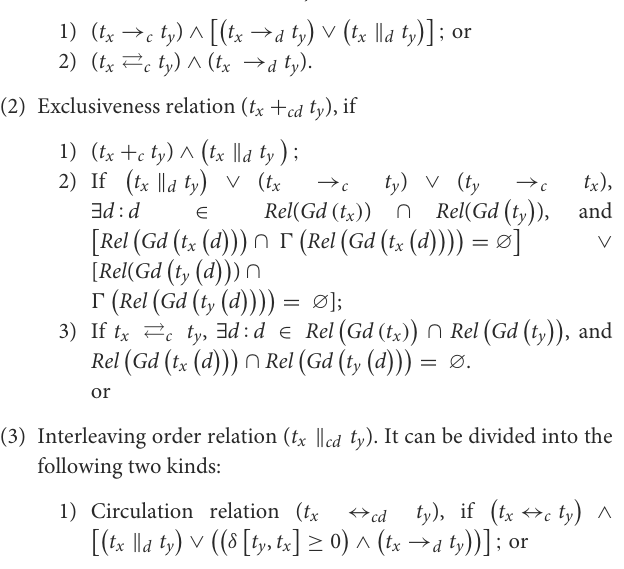
For the transition t y in Figure 2C, we have (1) Rel ( Gd t y ) is { a , b } , and Rel ( Gd t y ( a ) )(resp. Rel ( Gd t y ( b ) ) (cid:0) (cid:1) (cid:0) (cid:1) (cid:0) (cid:1) is a > 0 (resp. b ≤ 0) in guards related to t y ; and (2) Ŵ ( Rel Gd t y ) is the set of final values of { a , b } in (cid:0) (cid:0) (cid:1)(cid:1) Rel ( Gd t y ), and Ŵ ( Rel Gd t y ( a ) )(resp. Ŵ ( Rel Gd t y ( b ) ) (cid:0) (cid:1) (cid:0) (cid:0) (cid:1)(cid:1) (cid:0) (cid:0) (cid:1)(cid:1) is a = 3 (resp. b = 5 − 4 = 1) in Rel ( Gd t y ). (cid:0) (cid:1) The transition pairs’ behavioral relations in a WFD-net system depend on their weak behavioral relations, data dependencies, and guard functions. The following behavioral relations compose the behavioral profile of a WFD-net system. Definition 8 (Behavioral profile, BP). Given a WFD-net system ( ND , M 0 ) = ( P , T , F , M 0 , D , Guard , R , W , De , Gd ) and a pair of transitions t x , t y ∈ T , we